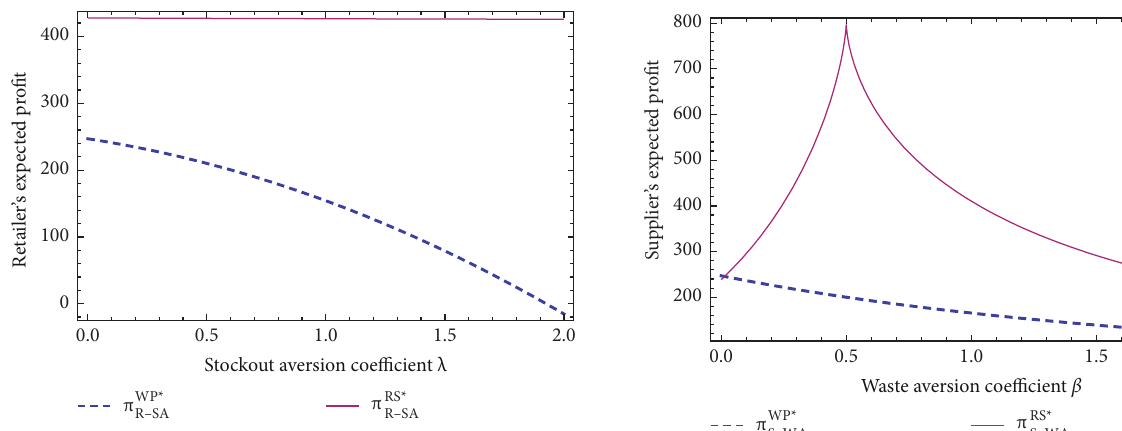
Figure 4: Effect of λ on retailer’s expected profit.